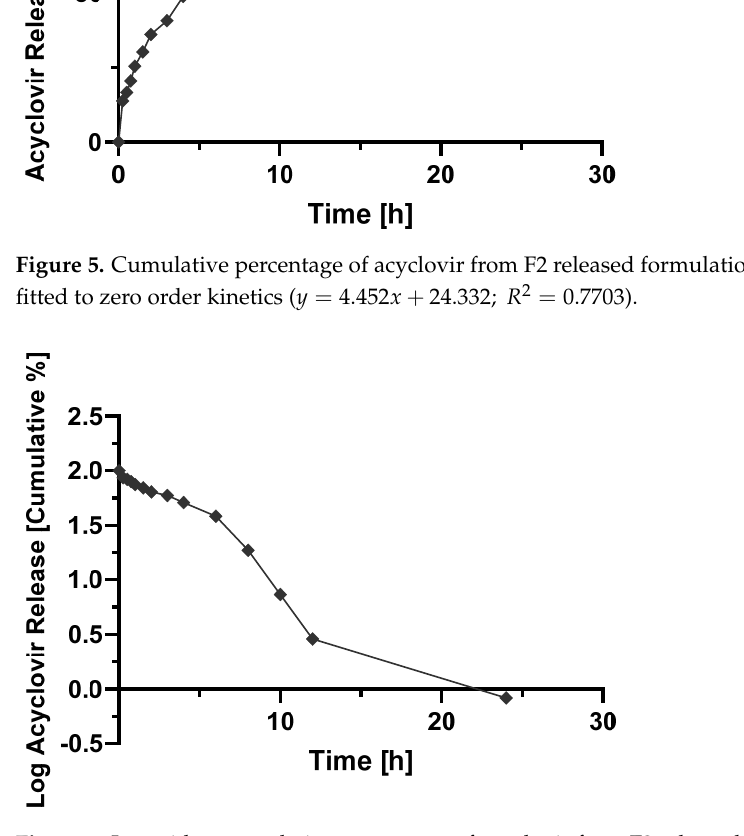
Figure 6. Logarithm cumulative percentage of acyclovir from F2 released formulation as a function of time (h) fitted to first order kinetics ( y = − 0.1134 x + 2.0381; R 2 = 0.940 ).